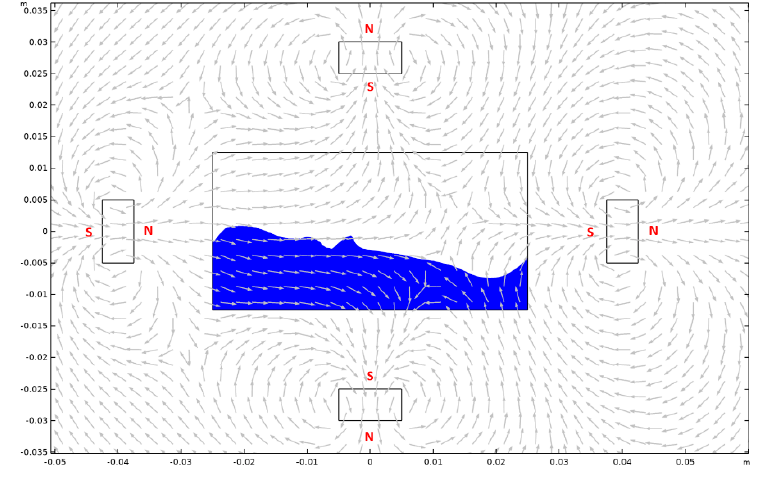
Figure A28. Case 14.